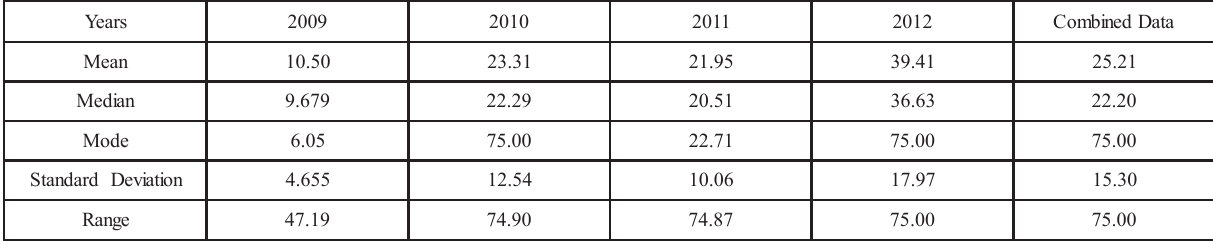
TABLE 1. DESCRIPTIVE STATISTICS OF VISIBILITY DATA